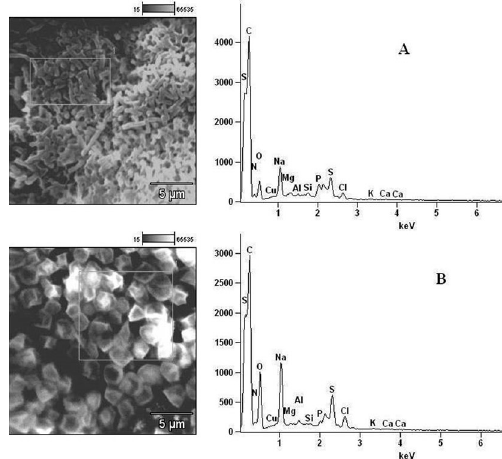
Fig. 7. Elemental components of (A) extract-untreated S. flexneri and (B) extract-treated S. flexneri .